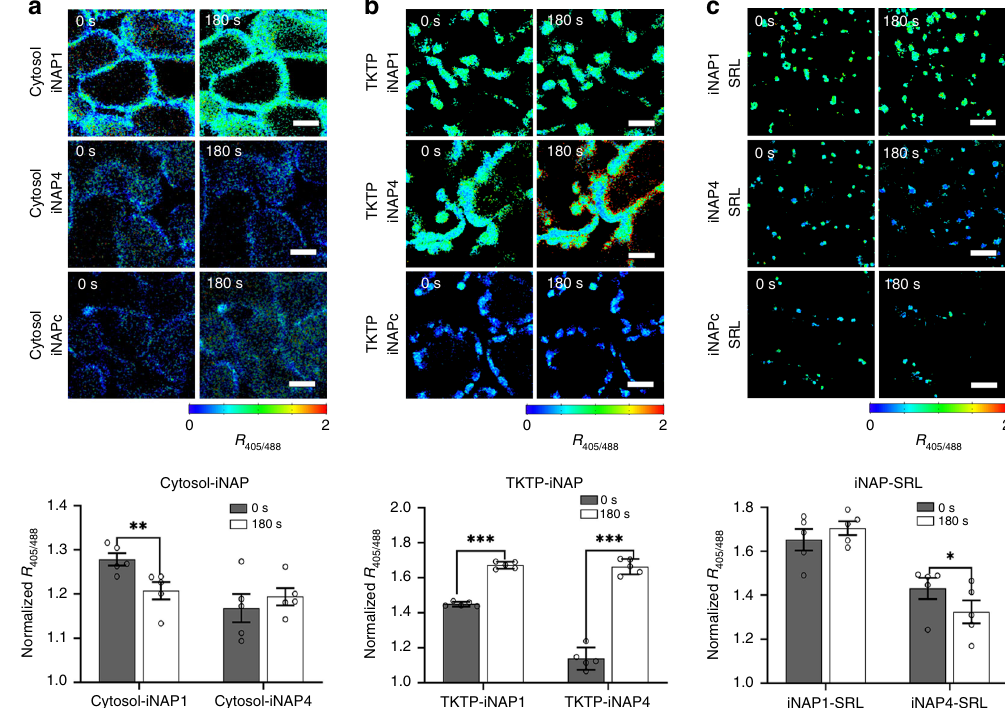
Fig. 1 Light responses of iNAP sensors in different compartments of 10-day-old cotyledon mesophyll. a Seedlings expressing cytosolic iNAP1, iNAP4, and iNAPc. b Seedlings expressing stromal iNAP1, iNAP4, and iNAPc, and c seedlings expressing peroxisomal iNAP1, iNAP4, and iNAPc were continuously illuminated for 180 s at 296 μ mol m − 2 s − 1 ( n = 5; error bars ± SEM). Emissions at 520 nm after sequential excitation at 405 nm and 488 nm were recorded, and the ratios of the two emissions ( R 405/408 ) are presented in pseudocolor image, where high ratios (red) correspond to high NADPH levels. Scale bars, 20 μ m. Asterisks indicate statistical signi fi cance as determined using paired t -test: * P < 0.05, ** P < 0.01, *** P <